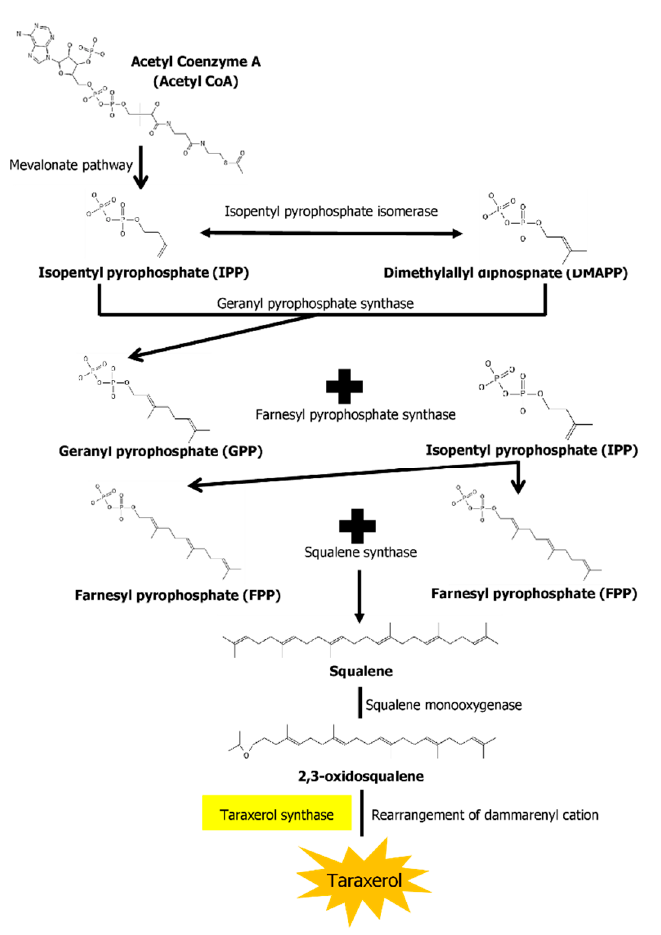
Figure 2. A summary of the biosynthesis pathway of taraxerol. With the aid of taraxerol synthase, dammarenyl cation undergoes rearrangements to produce taraxerol. dammarenyl cation undergoes rearrangements to produce